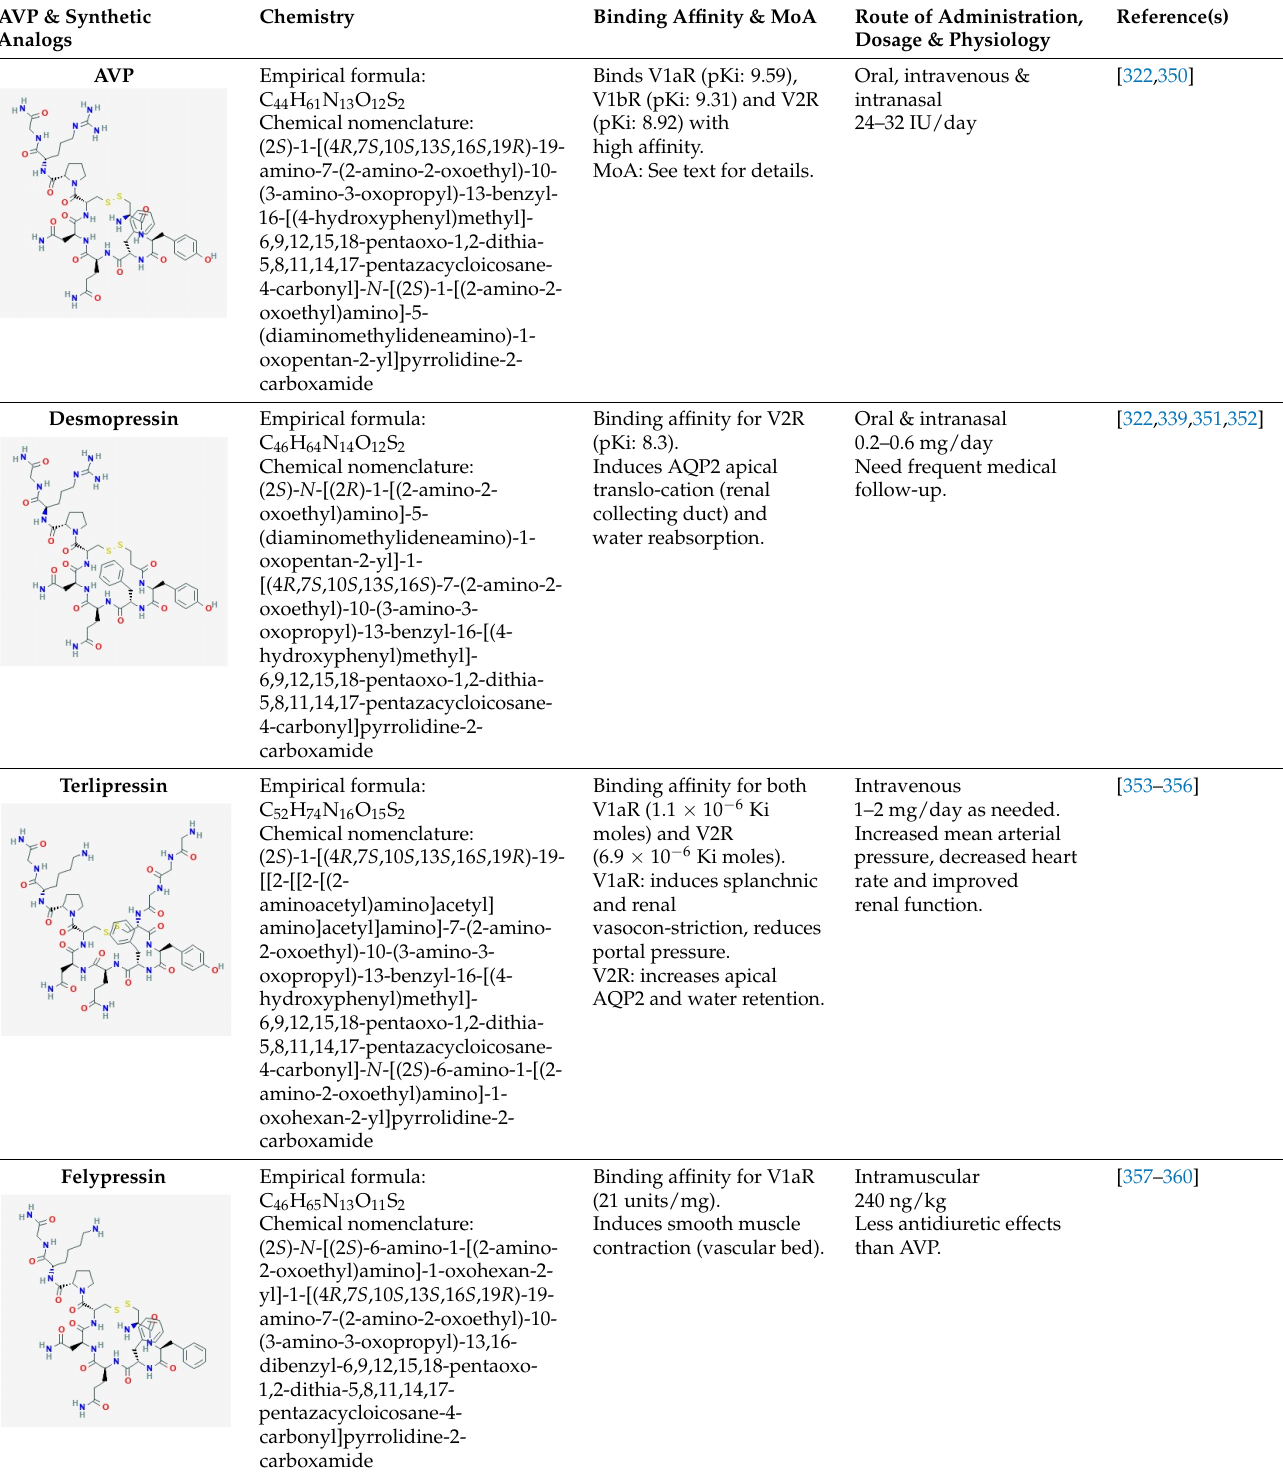
Table 3. AVP synthetic